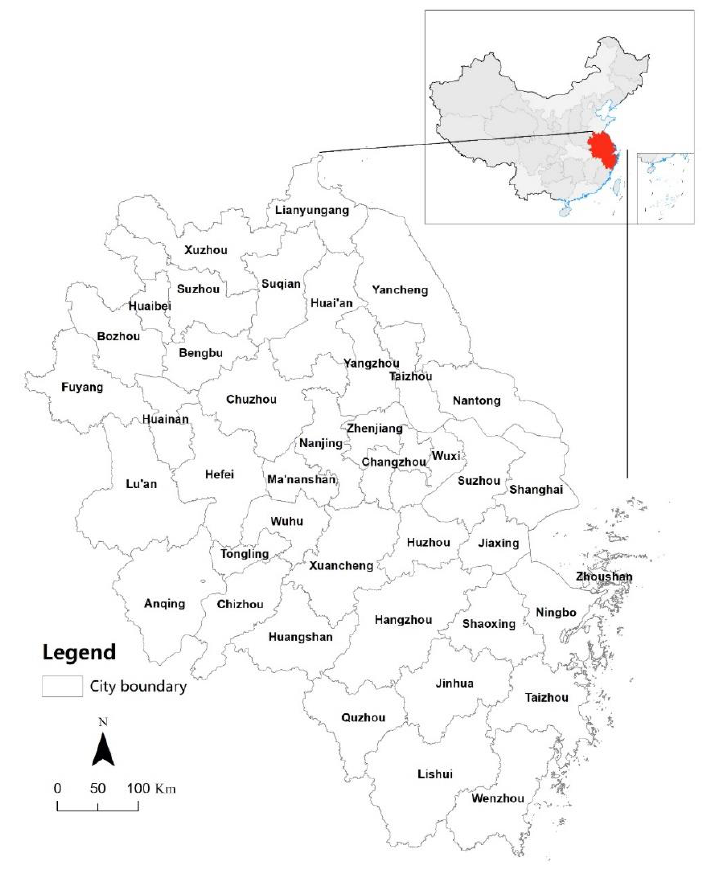
Figure 2. The study area.